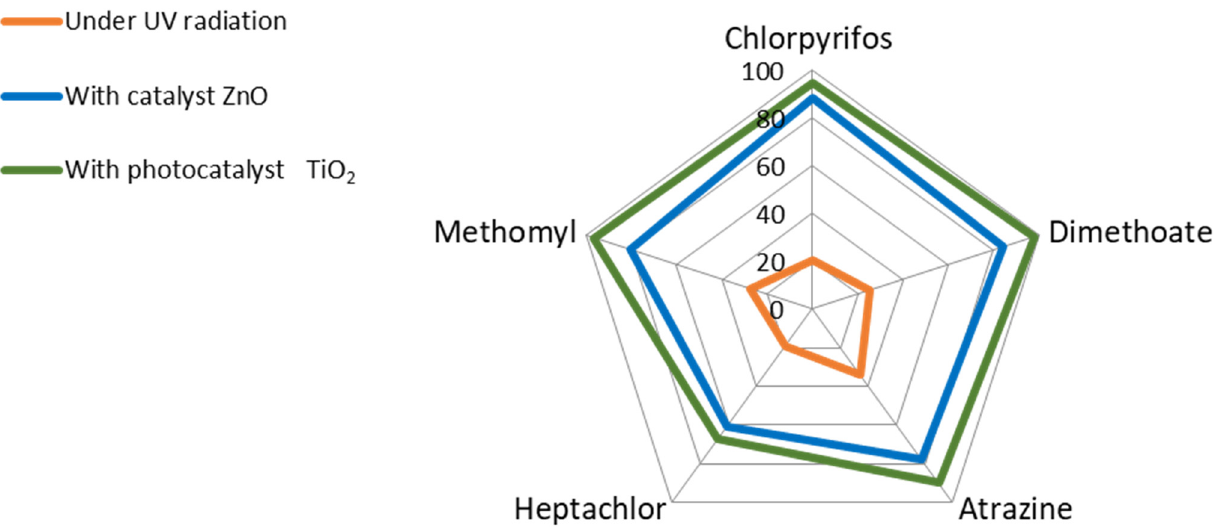
Figure 4. Percentage degradation of the five pesticides after 20 h UV irradiation, without a photocatalyst (orange), with ZnO (blue), and with TiO 2 (green).